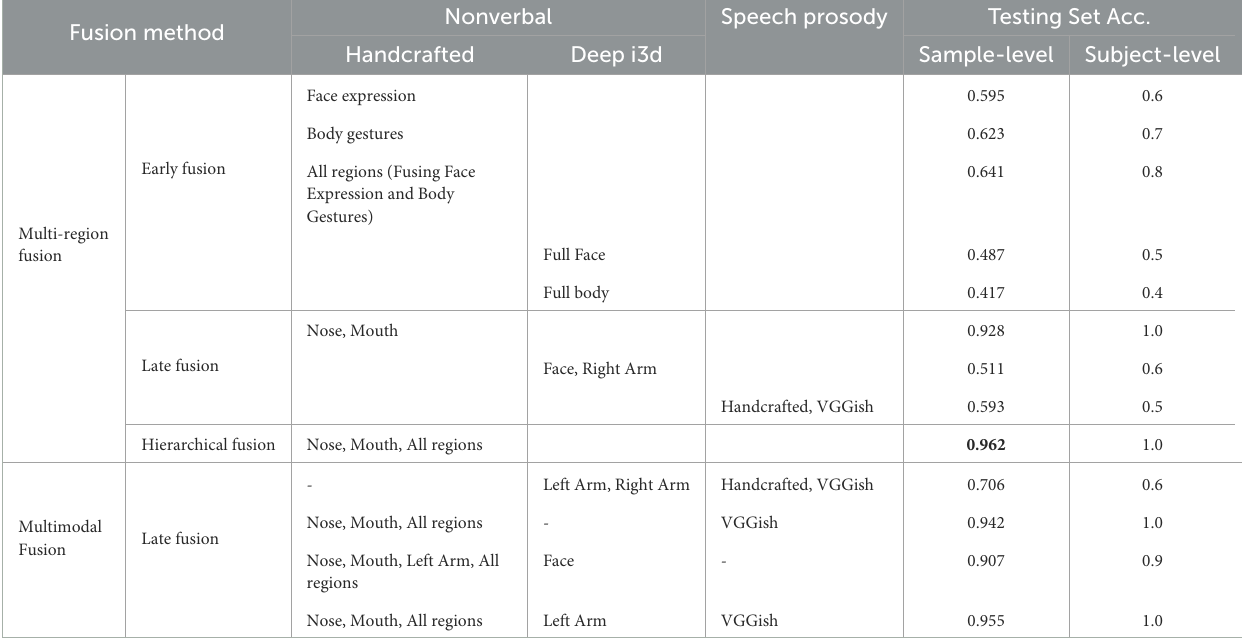
TABLE 4 Results of different multimodal fusion approaches—showing the strongest results from the hierarchical (hybrid) fusion, and confirming the strength of our region-based